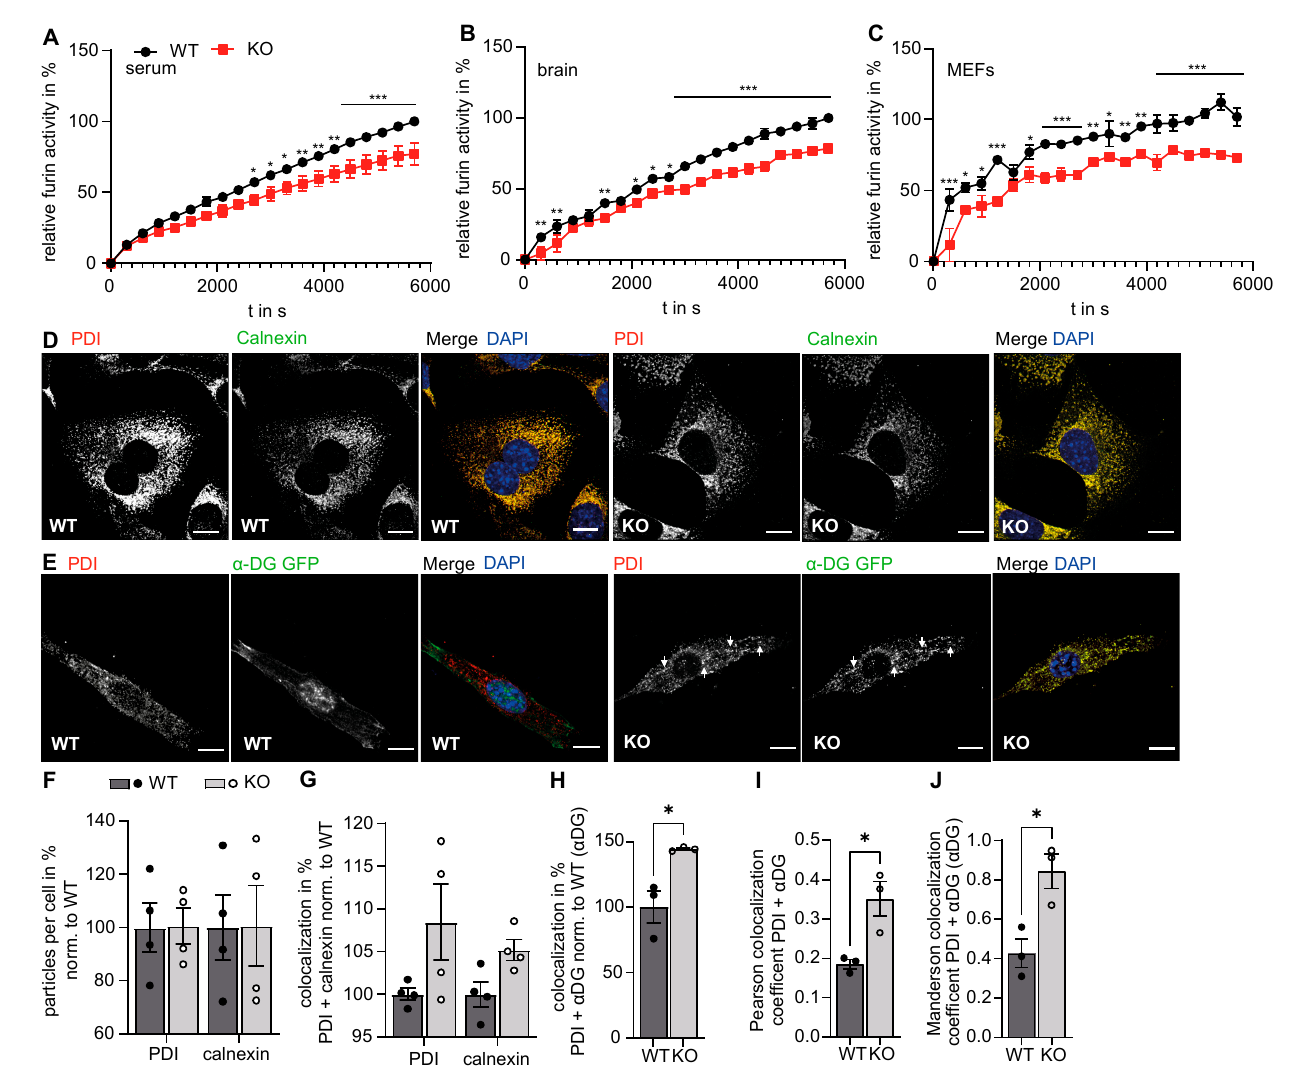
Figure 4. Loss of GMPPA results in functional alterations of the ER and the Golgi apparatus. ( A – C ) Furin activity assay for ( A ) serum (n = 4 mice per group), ( B ) brain lysates (n = 4 mice per group), and ( C ) MEF lysates (n = 3 experiments per group, 2-way-ANOVA with Bonferroni post-hoc analysis). ( D ) Representative images of WT and GMPPA KO MEFs stained for PDI and calnexin (scale bars: 5 µm). ( E ) Representative images of WT and GMPPA KO MEFs transfected with α -DG-GFP and stained for PDI (scale bars: 8 µm). White arrows indicate colocalized structures. ( F , G ) ImageJ analysis (ComDet plugin) does not show any differences between genotypes in ( F ) particle numbers as well as ( G ) colocalization between PDI and calnexin (n = 4 experiments per group, 5 images per genotype per experiment, 2-way-ANOVA with Bonferroni post-hoc analysis). ( H ) ImageJ analysis (ComDet plugin) shows increased colocalization between α -DG-GFP and PDI in KO cells (n = 3 experiments per group, 5 images per genotype per experiment, two tailed Student’s t -Test). ( I,J ) Colocalization analysis with the Coloc2 ImageJ plugin that measures the (I) Pearson’s colocalization coefficient as well as the (J) Manderson overlap coefficient showing increased colocalization between α -DG-GFP and PDI in KO cells (n = 3 experiments per group, 5 images per genotype per experiment, two tailed Student’s t-Test, and 2-way-ANOVA with Bonferroni post-hoc analysis). * indicates p < 0.05, ** p < 0.01, and *** p < 0.001. To get an idea about the trafficking of mannosylated proteins from the ER to the Golgi apparatus and because GMPPA KO mice show a reduced abundance of α -DG in the sarcolemma of skeletal muscle fibers [13], we transfected WT and KO MEFs with